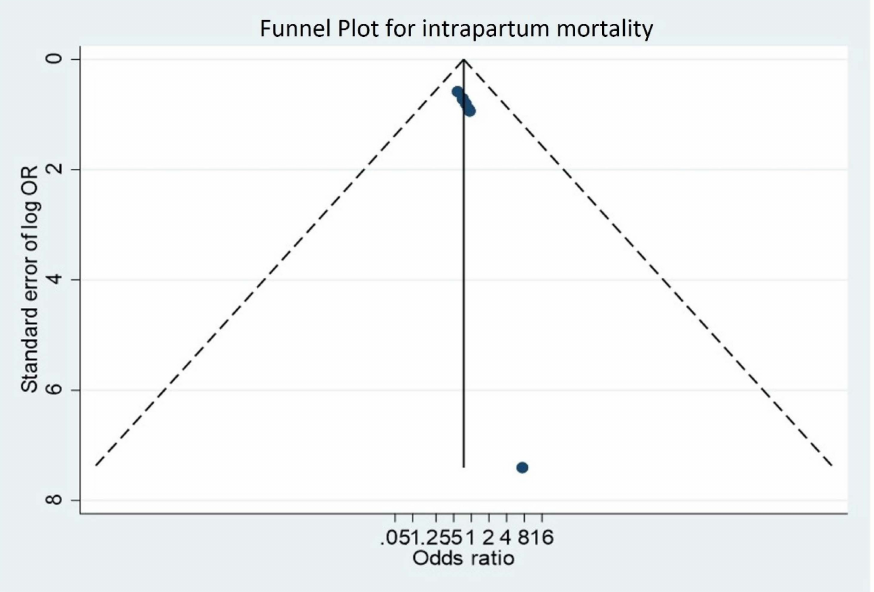
Figure 5. Funnel plot (asymmetry